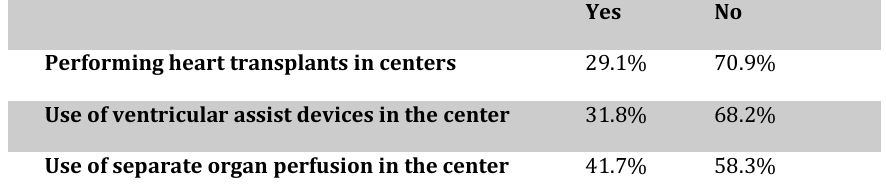
Table 2. Heart transplant